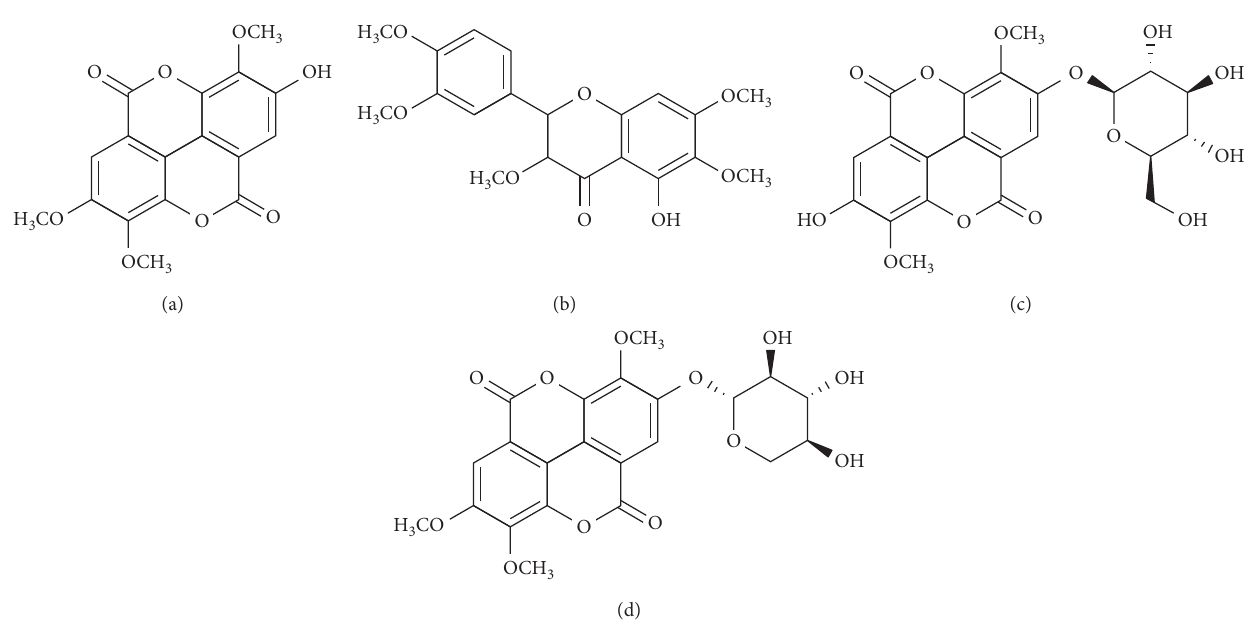
Figure 1: The chemical structures of TMEA (a), IS (b), DMAG (c) and DOMA